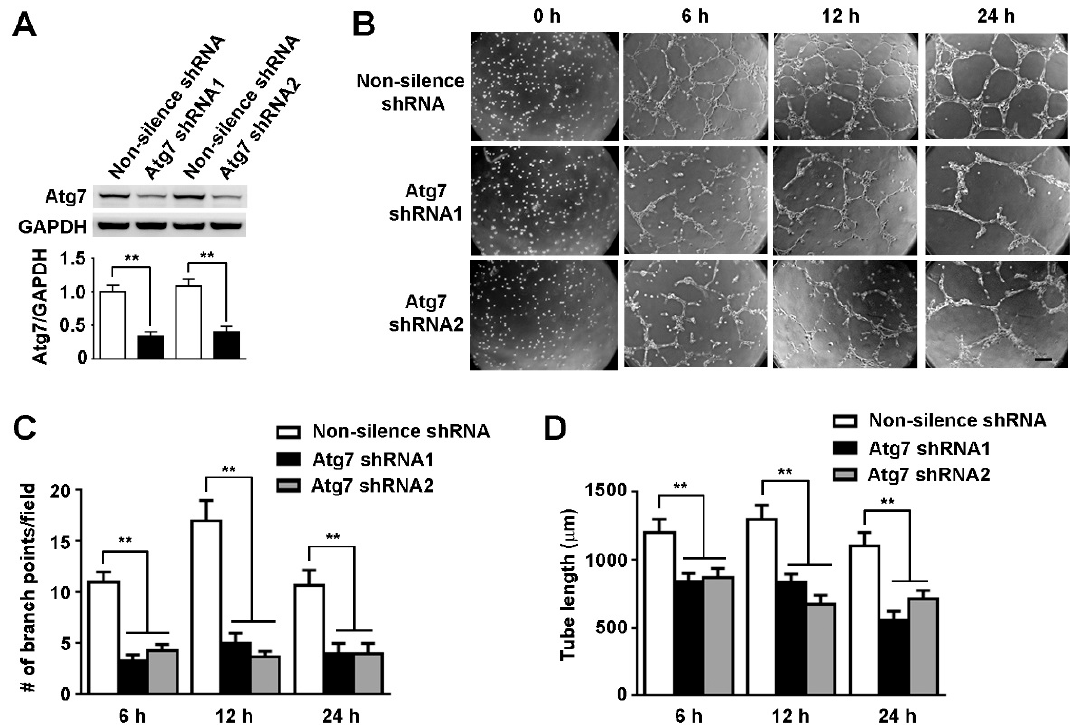
Figure 2. Knockdown of Atg7 inhibited angiogenesis of brain microvascular endothelial cells. ( A ) Human brain microvascular endothelial cells (HBMEC) were stably transfected with Atg7-specific shRNA construct, Atg7 shRNA1, and Atg7 shRNA2, respectively. HBMEC stably transfected with non-silencing shRNA were served as the control. Then the protein levels of Atg7 were examined by western blot, with glyceraldehyde-3-phosphate dehydrogenase (GAPDH) as the loading control. The relative expression level of Atg7 and Atg7/GAPDH were calculated by measuring the band intensity using ImageJ software. ** p < 0.01; ( B ) Tube formation assays were performed with HBMEC stably transfected with Atg7 shRNA1 and Atg7 shRNA2, respectively, with non-silencing shRNA as the control. Then the images were captured under an inverted microscope at indicated times. The representative images from three independent experiments were shown. Scale, 200 µ m; ( C , D ) To quantify the results of tube formation assays in ( B ), the number of branch points were counted and the tube length were calculated. ** p < 0.01.